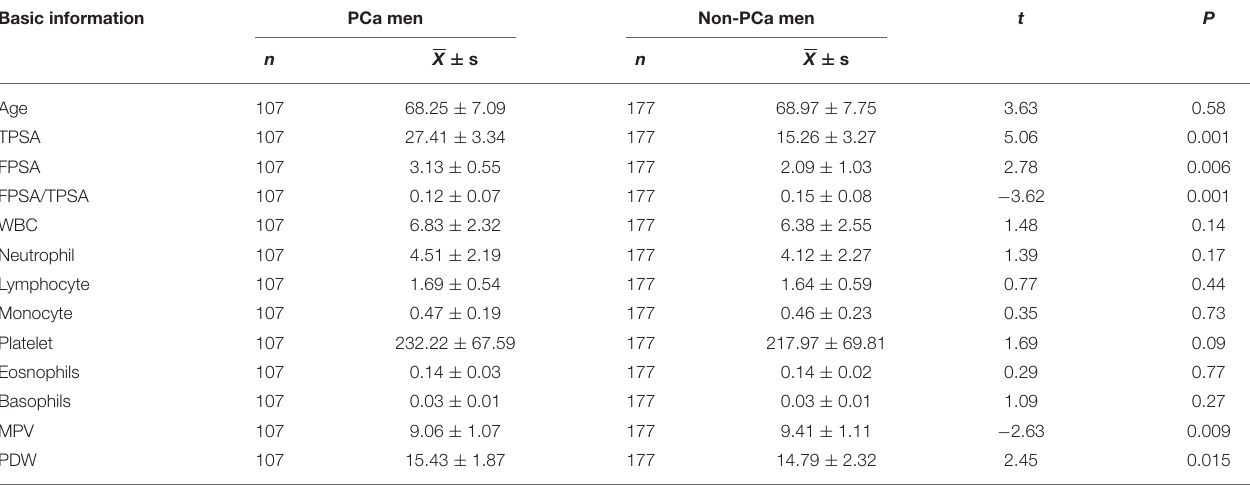
TABLE 1 | The basic information of prostate cancer (PCa) and non-PCa in men. Basic information